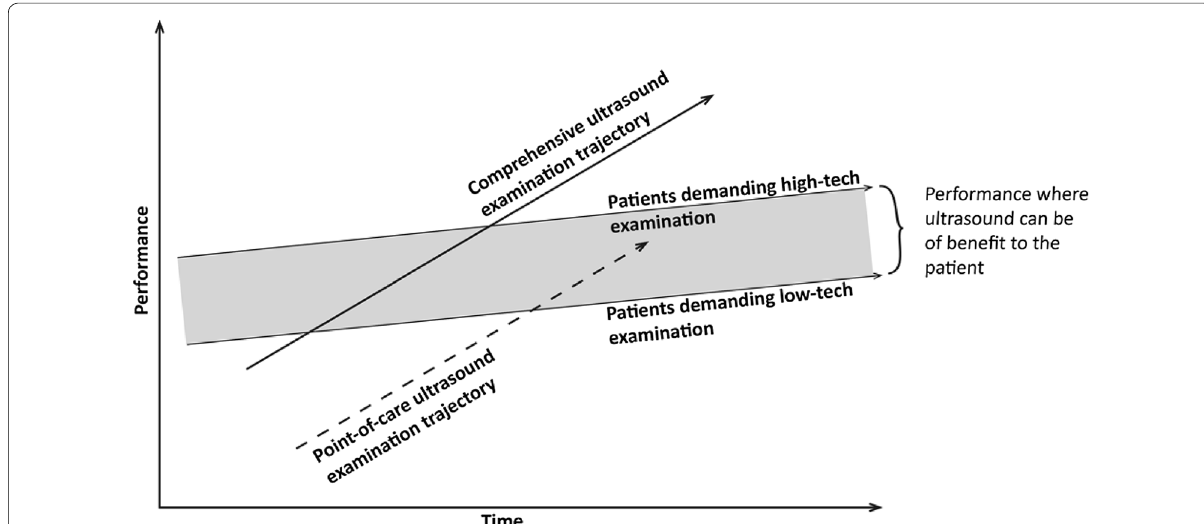
Fig. 3 Point-of-care Ultrasound Expressed as a Disruptive Innovation. In this context, the conventional comprehensive ultrasound examination and the point-of-care examination are two parallel trajectories. PoCUS examination is a disruptive innovation, as its speed, cost, and availability differ from that of the conventional comprehensive examination. The speed and availability enable the examination to become an extension to any physical examination at any time. The point-of-care examination is inferior to comprehensive examinations, but meets the low end of customer demand (Adapted from Christensen